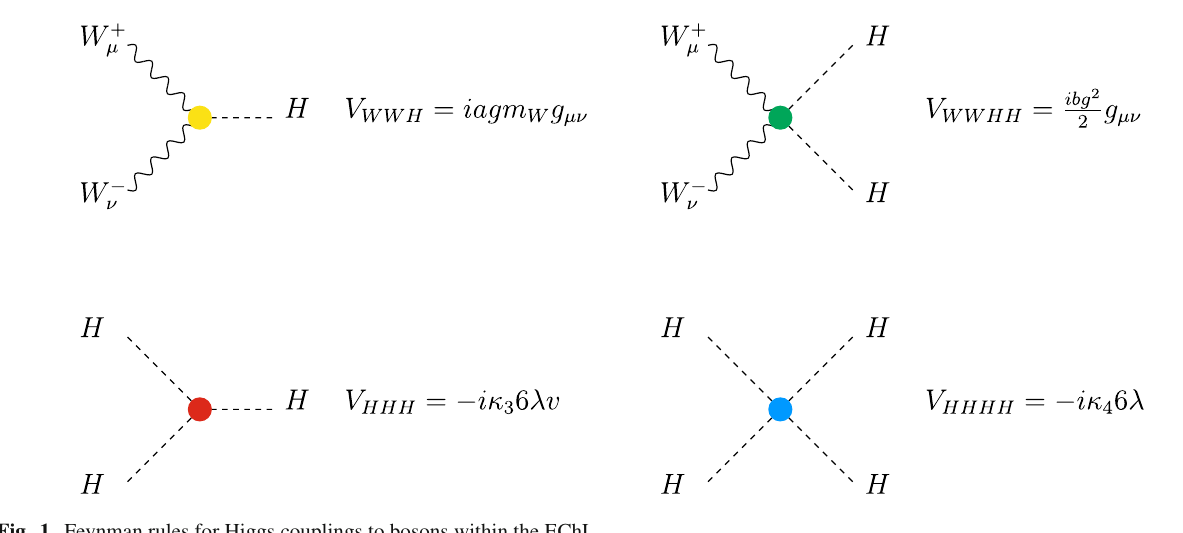
Fig. 1 Feynman rules for Higgs couplings to bosons within the